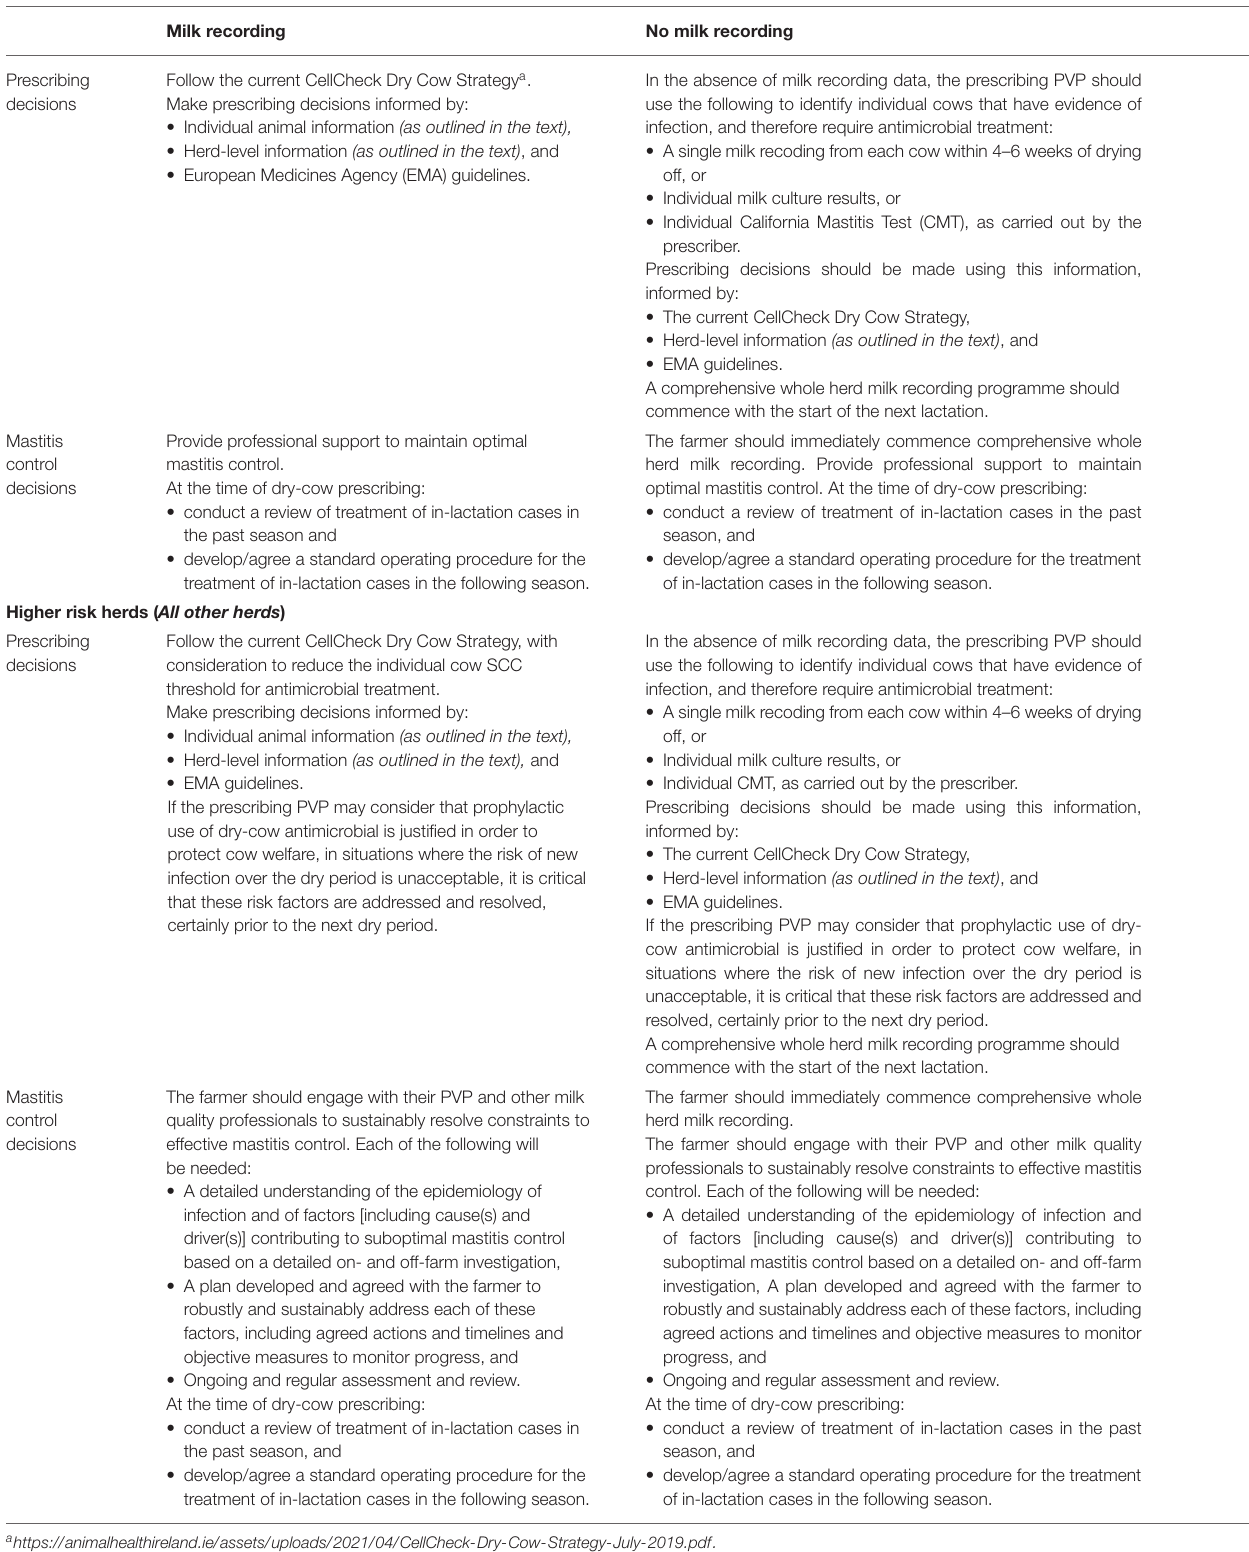
TABLE 2 | Proposed guidelines for the prescribing private veterinary practitioner (PVP) to support prescribing and mastitis control decisions at drying off. Lower risk herds (Those where there is objective evidence that mastitis is under good control and the prevalence of infection is consistently